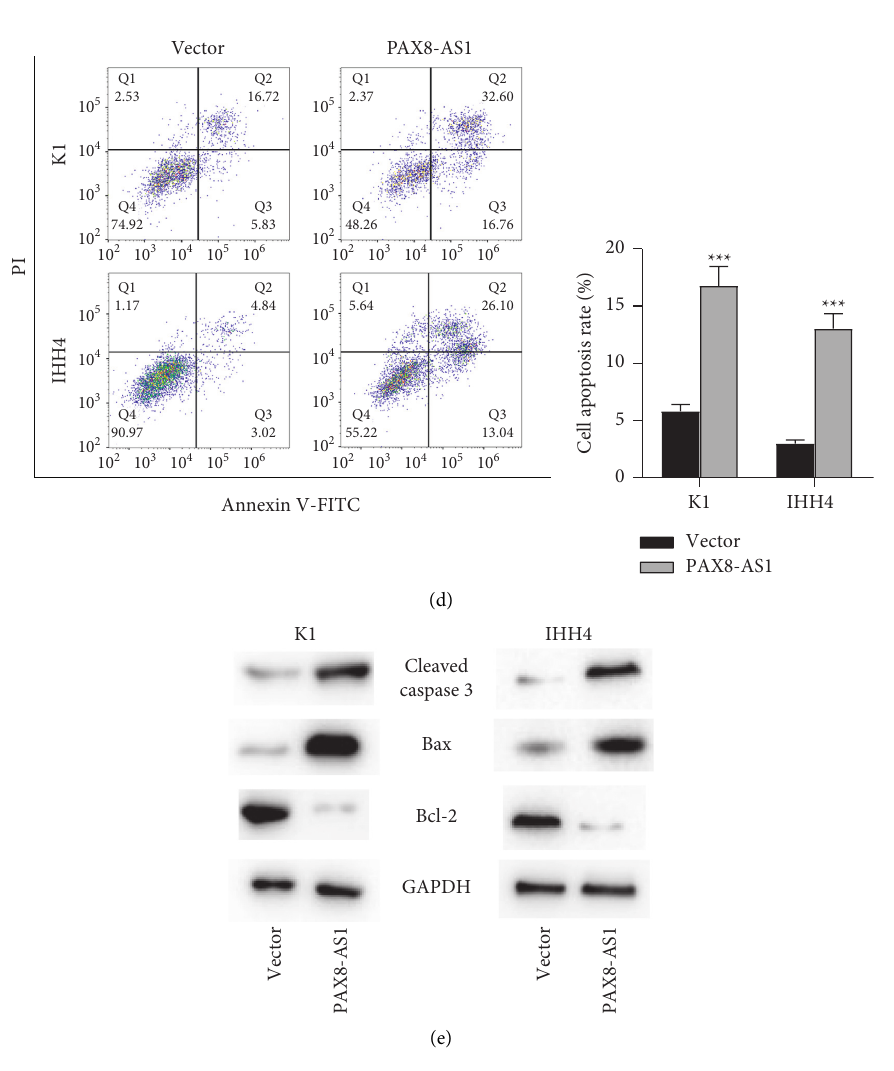
Figure 2: Overexpression of PAX8-AS1 impedes the cell proliferation and enhances apoptosis. Note. (a) The transfection efficiency of PAX8-AS1 in PTC K1 and IHH4 cells was detected by qRT-PCR; (b) MTTassay was conducted to separately detect the optical density values at 490nm at 24, 48, and 72 h in K1 and IHH4 cells after overexpressing PAX8-AS1; (c) cell proliferation was examined in K1 and IHH4 cells after PAX8-AS1 overexpression by EdU assay; (d) flow cytometry was used to analyze the scatter patterns of cell cycle distribution of K1 and IHH4 cells after PAX8-AS1 overexpression; (e) the protein bands of apoptosis-related proteins in K1 and IHH4 cells were detected by western blot. ∗ P < 0 . 05 , ∗∗ P < 0 . 01 , and ∗∗∗ P < 0 .